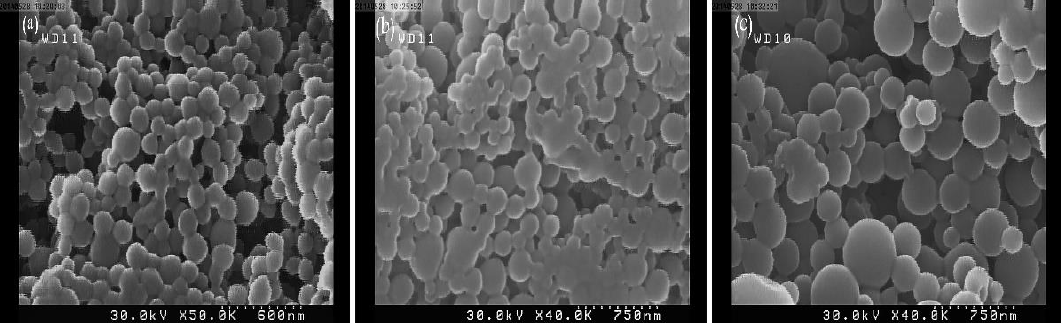
Fig. 1. FE-SEM micrographs of gelatin nanoparticles in different gelatin concentrations of 1.25 wt% (a); 2wt% (b) and 2.25 wt%